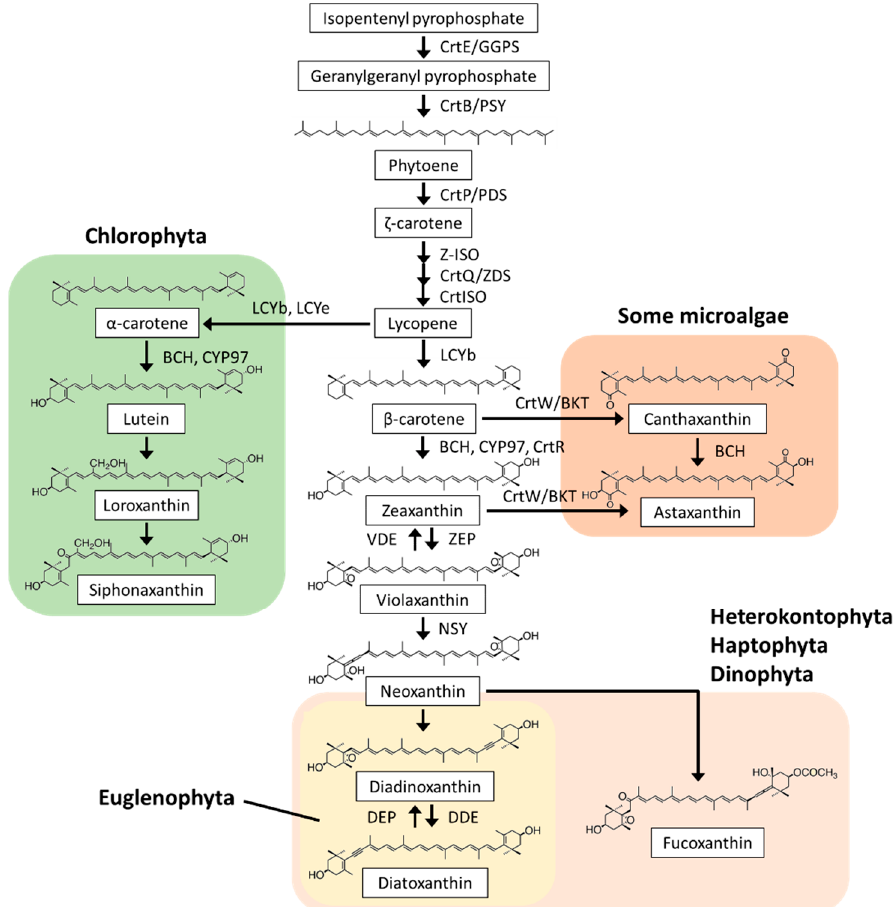
Figure 1. Carotenoid structures and biosynthesis in microalgae. Most microalgae contain a series of carotenoid compounds, from isopentenyl pyrophosphate to violaxanthin; the exception are red algae (e.g., Cyanidioschyzon merolae ), which lack violaxanthin. α -carotene, lutein, loroxanthin, and siphonaxanthin are found in Chlorophyta, diadinoxanthin and diatoxathin are found in Hetero- kontophyta, Haptophyta, Dinophyta, and Euglenophyta, fucoxanthin is found in Heterokonto- phyta, Haptophyta, and Dinophyta, and canthaxanthin and astaxanthin are found in some micro- algae (e.g., Haematococcus pluvialis , Chromochloris zofingiensis , and Euglena gracilis ). The synthetic genes of loroxanthin, siphonaxanthin, diadinoxanthin, and fucoxanthin have not yet been identi- fied. Violaxanthin and zeaxanthin are interconverted by VDE and ZEP, respectively, in the violax- anthin cycle via antheraxanthin; diadinoxanthin and diatoxanthin are similarly interconverted by DDE and DEP, respectively, in the diadinoxanthin cycle. CrtE/GGPS, geranylgeranyl pyrophos- phate synthase; CrtB/PSY, phytoene synthase; CrtP, PDS, phytoene desaturase; Z-ISO, ζ -carotene isomerase; CrtQ/ZDS, ζ -carotene desaturase; CrtISO, prolycopene isomerase; LCYb, lycopene β - cyclase; LCYe, lycopene ε -cyclase; BCH, CYP97, and CrtR, carotene hydroxylase; ZEP,